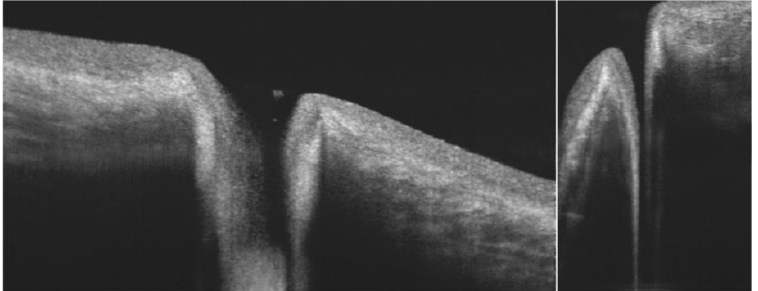
Figure 10. Lacrimal punctal region by optical coherence tomography (OCT). The anatomy of vertical canaliculus and lacrimal punctal region can be directly imaged by commercial OCT systems [89,90].